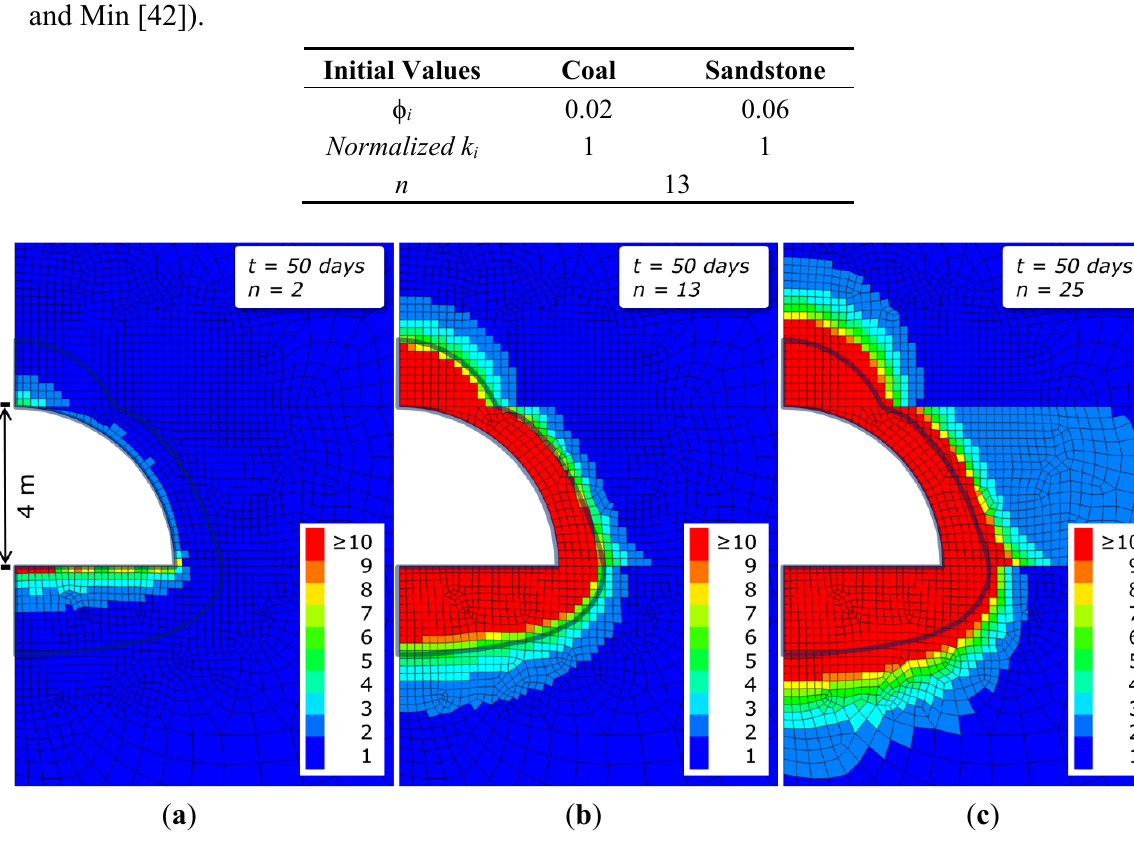
Figure 13. Porosity and permeability is expressed as function of volumetric strain increment following Chin et al. [40] with porosity sensitivity exponents of ( a ) n = 2; ( b ) n = 13; and ( c ) n = 25. The grey solid line represents the 200 °C